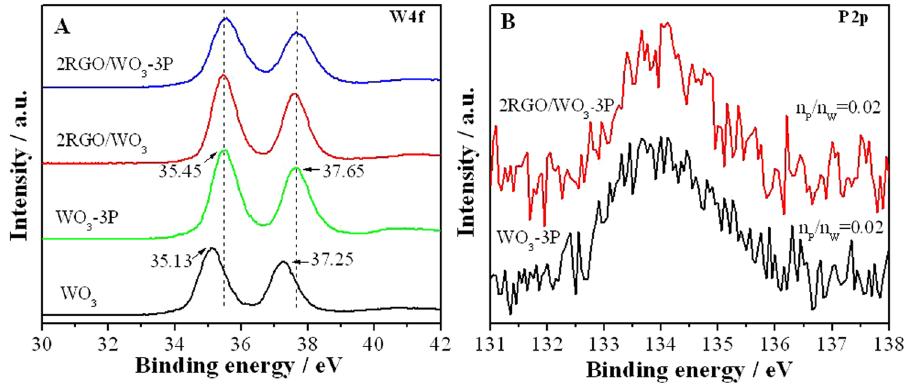
Figure 2. W4f XPS spectra of WO 3 , WO 3 -3P and 2RGO/WO 3 -3P ( A ), P2p XPS spectra of WO 3 -3P and 2RGO/ WO 3 -3P ( B